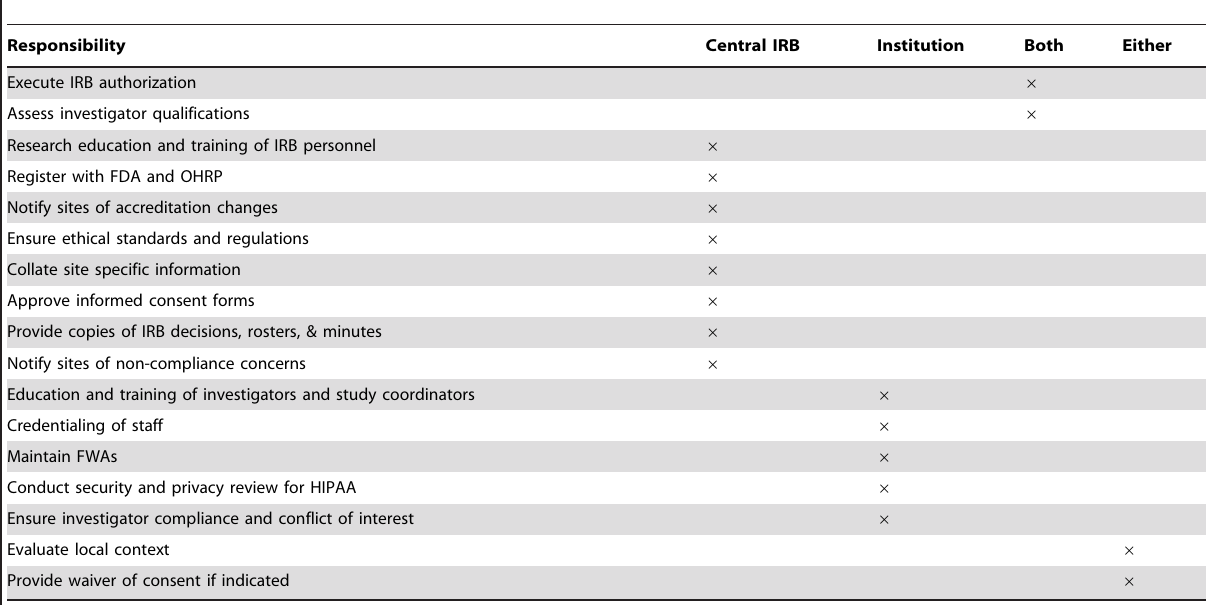
Table 2. Responsibilities of Institutions and Central IRBs for Multicenter Clinical Trial Protocols*.